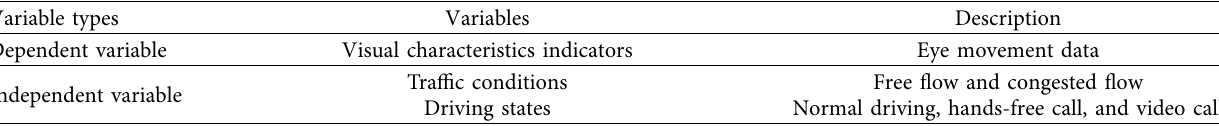
Figure 1: Overall design framework of simulated driving test. Table 1: Test